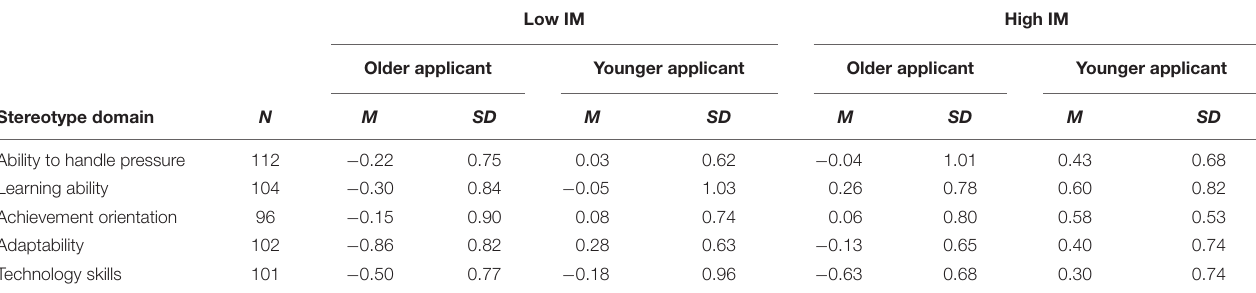
Low IM High IM Older applicant Younger applicant Older